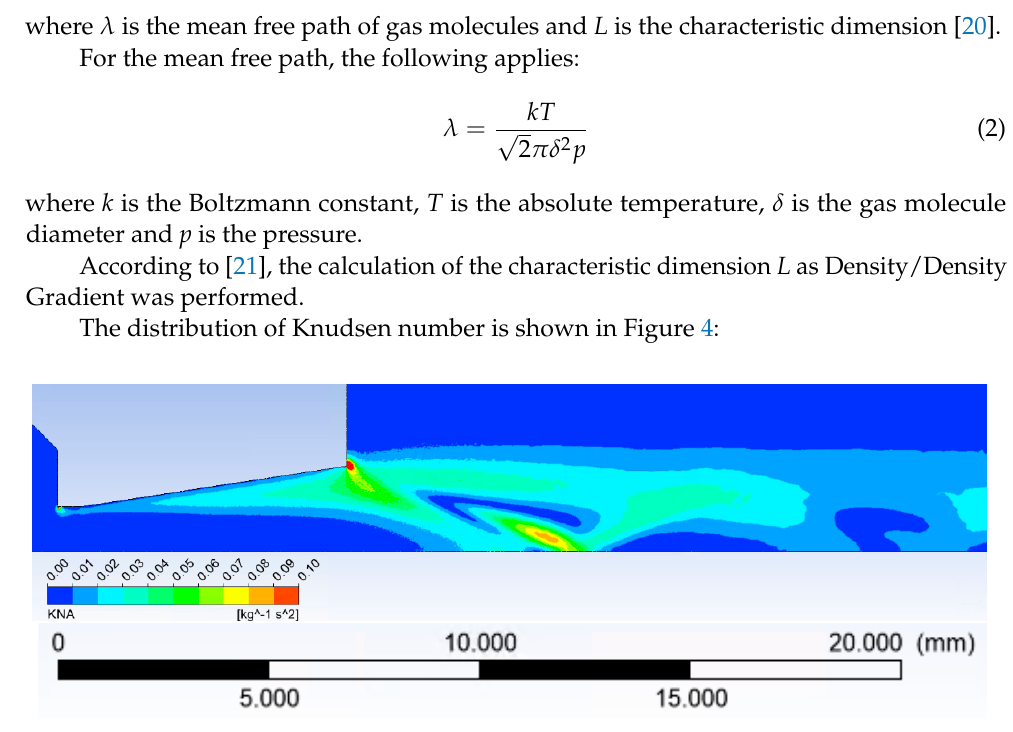
Figure 4. The distribution of the Knudsen